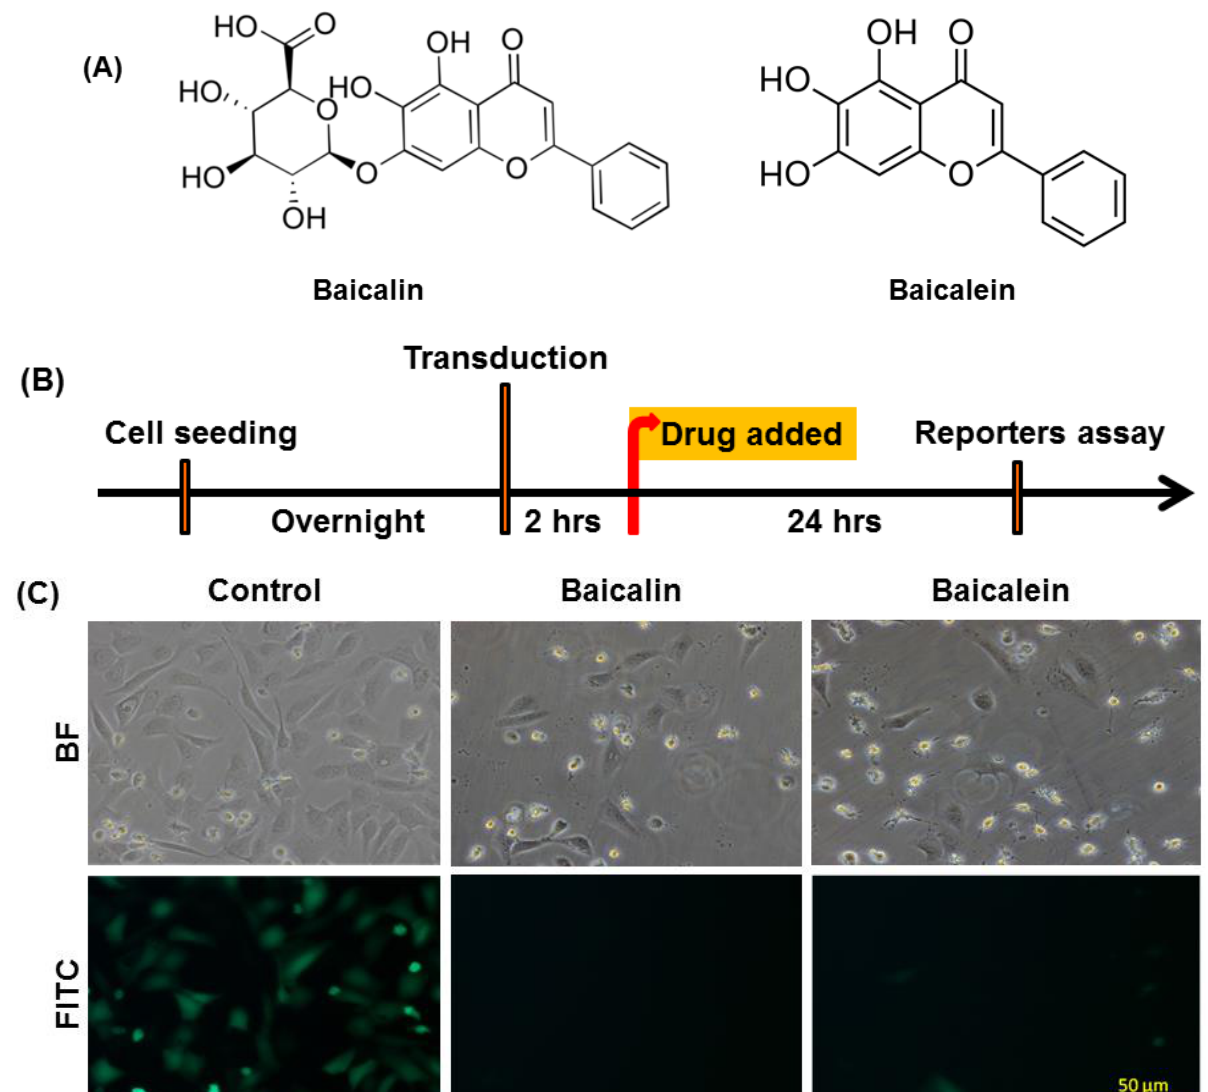
Figure 7. ( A ) Chemical structure of baicalin and baicalein [50]. ( B ) Schedule detailing BacMam virus transduction and plant-derived compounds treatment in U-2OS cells after 2 h of BacMam transduction. ( C ) The effects of baicalin and baicalein on BacMam-mediated replicon activity in U-2OS cells. U-2OS cells were transduced with vAc-CMV-CHIKV NS-EGFP BacMam at a multiplicity of infection (MOI) of 10. After 2 h, the transduced cells were treated with 56 nM of baicalin and 92 nM of baicalein. The replicon activity of CHIKV in mammalian cells using BacMam system at 1 dpt was examined under a fluorescence microscope with a FITC channel (lower panel) and a bright field (upper panel). The bar represents 50 µm.